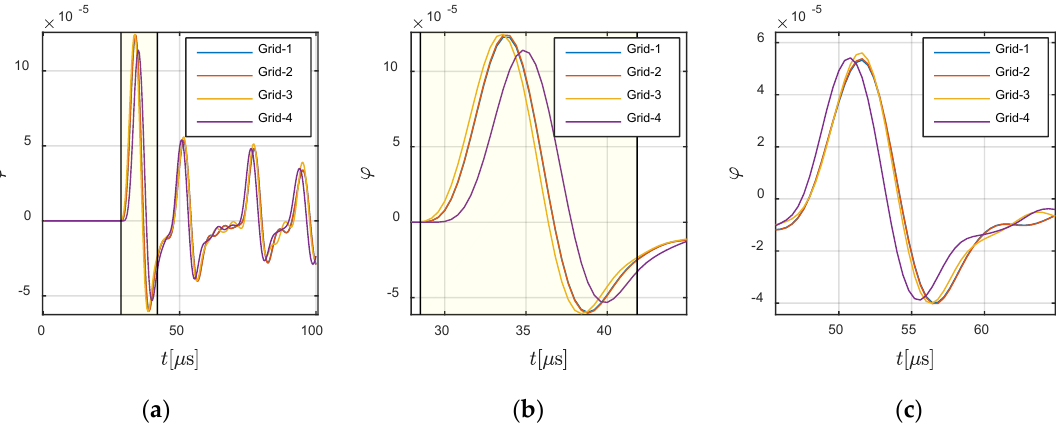
Figure 13. Responses at − 0.0700 m and 0 m in the fluid region: ( a ) global view and ( b , c ) local views.